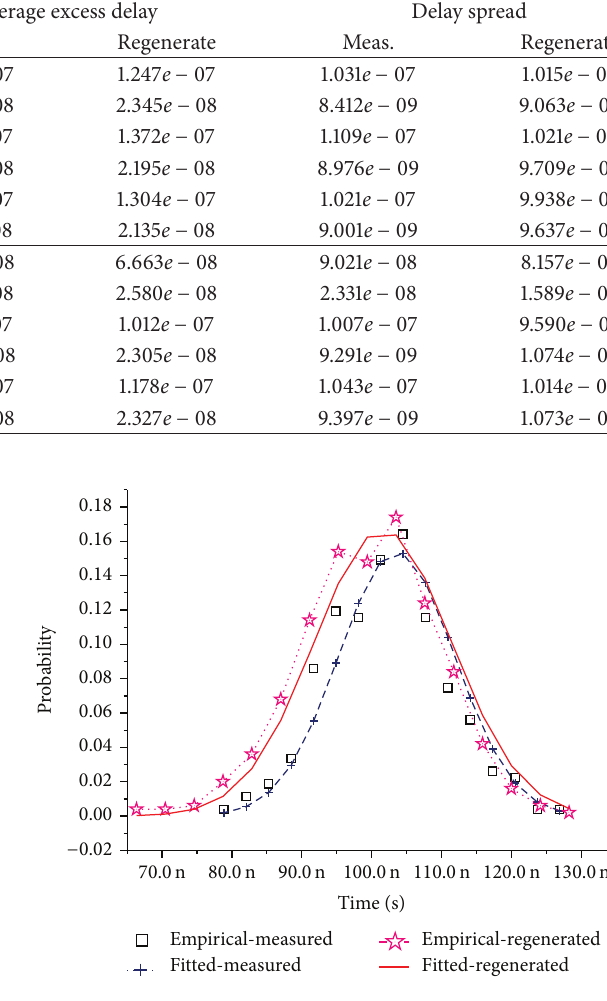
Figure 8: Comparison of the empirical distribution and fitted normal distribution of delay spread at 900 MHz in Scenario 1. “Measured” means that the data were obtained by experiments whereas “regenerated” means that they were obtained by channel